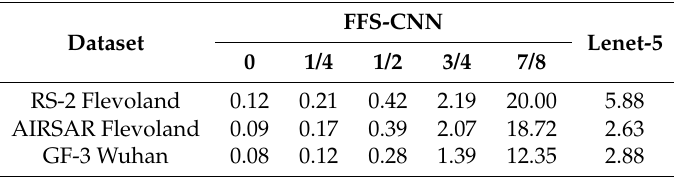
Table 9. The relationship between overlap ratio and classification time (min).